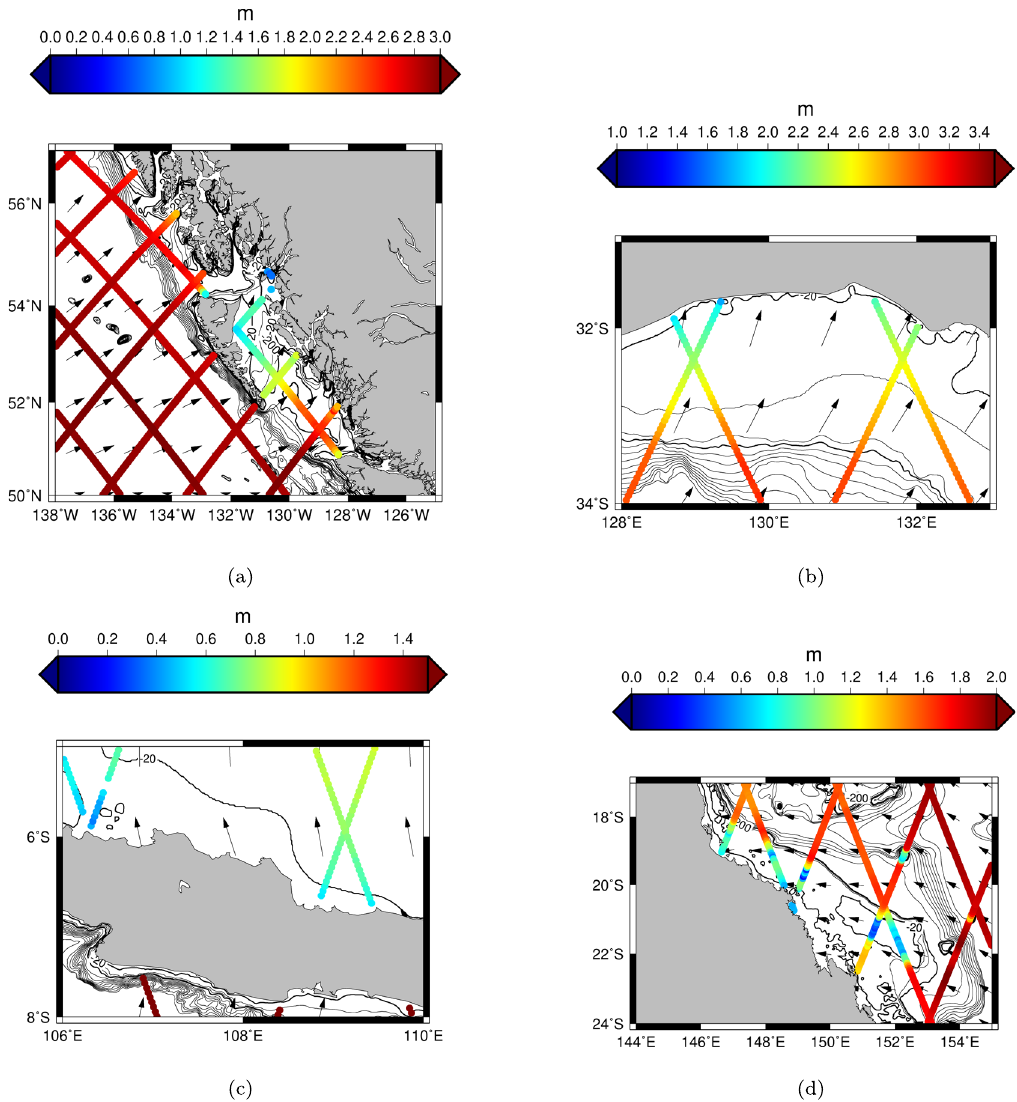
Fig. 2 Coastal changes of mean Signi fi cant Wave Height (SWH). Examples of coastal changes of mean SWH along the altimetry tracks (colour scale) in Alaska ( a ), South Australia ( b ), the island of Java in Indonesia ( c ) and in Great Barrier Reef region of East Australia ( d ). Bathymetry contours are plotted at intervals of 60 m from − 20 m until − 200 m depth and every 200 m until − 2000 m depth. The mean wave direction computed from the ECMWF ERA5 reanalysis is shown with